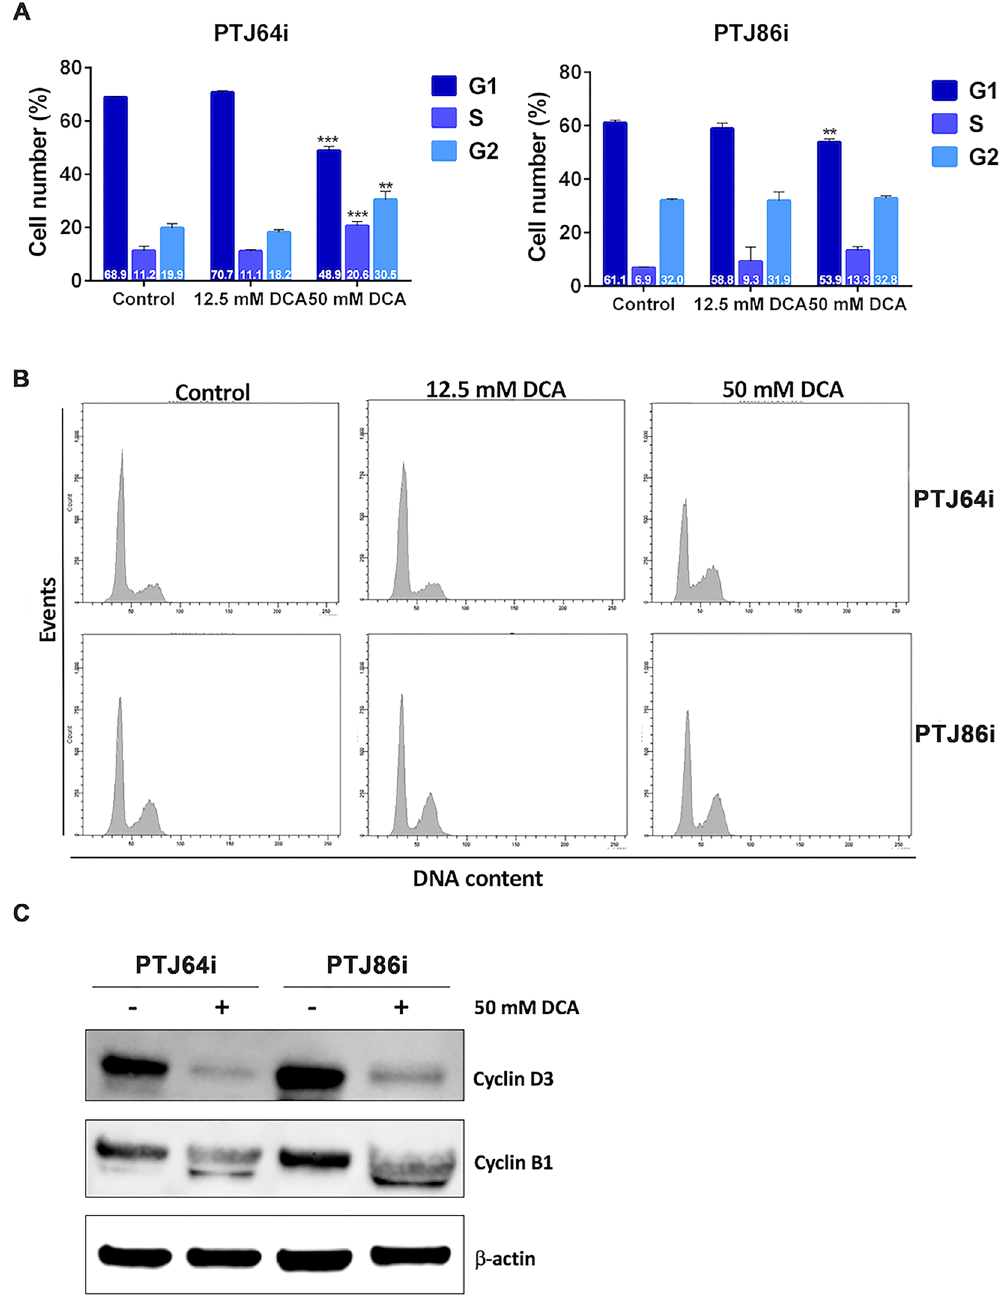
Figure 3. DCA affects cell cycle in PTJ64i and PTJ86i cell lines. (A) The histograms show the mean percentages of cells (values inside the bars) in the different cell phases, evaluated by flow cytometry, after 24-hour treatment with 12.5 or 50 mM DCA as compared to control. Results shown are the means ± SD of three independent experiments ( ** p < 0.01; *** p < 0.001); (B) Representative DNA distribution histograms of PGL cells exposed to DCA (12.5 mM and 50 mM) or vehicle (control) for 24 hours, as measured by flow cytometry; (C) Expression of cyclin D3 and cyclin B1 proteins after incubation of cells for 24 hours with vehicle or 50 mM DCA was analyzed by western blot using antibodies directed against the indicated proteins. Full–length western blots are included in Supplementary Information (Fig.